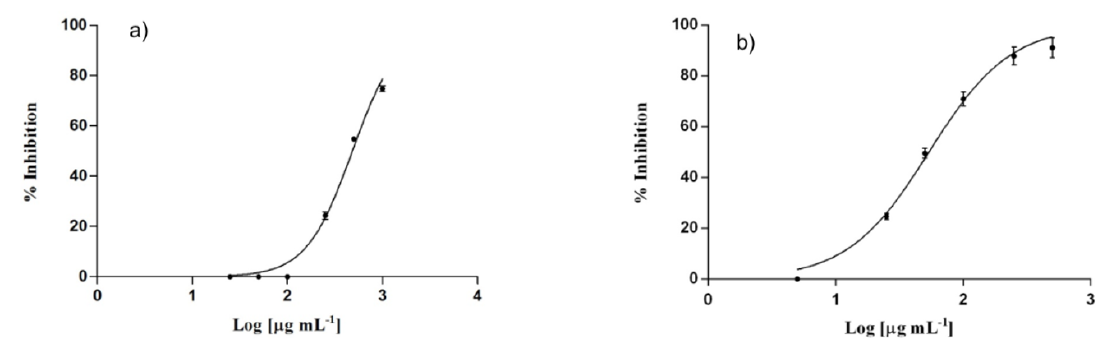
Figure 6. In vitro NO production inhibition of empty SLNs ( a ) and loaded SLNs ( b ).